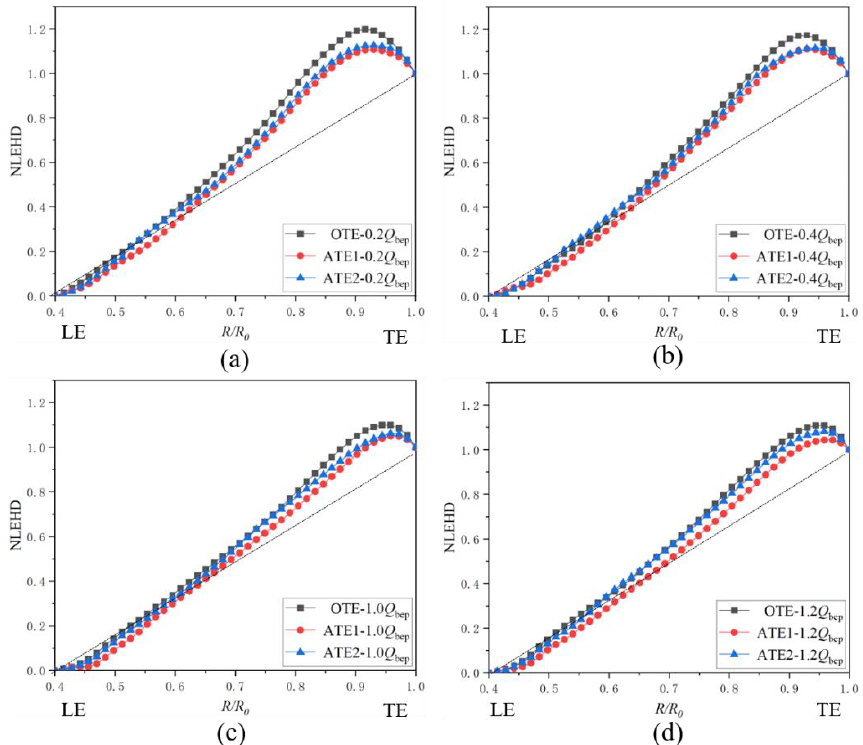
Figure 17. The nominalized local Euler head distribution curve at different flow rates: ( a ) 0.2 Q BEP ; ( b ) 0.4 Q BEP ; ( c ) 1.0 Q BEP ; and ( d ) 1.2 Q BEP .